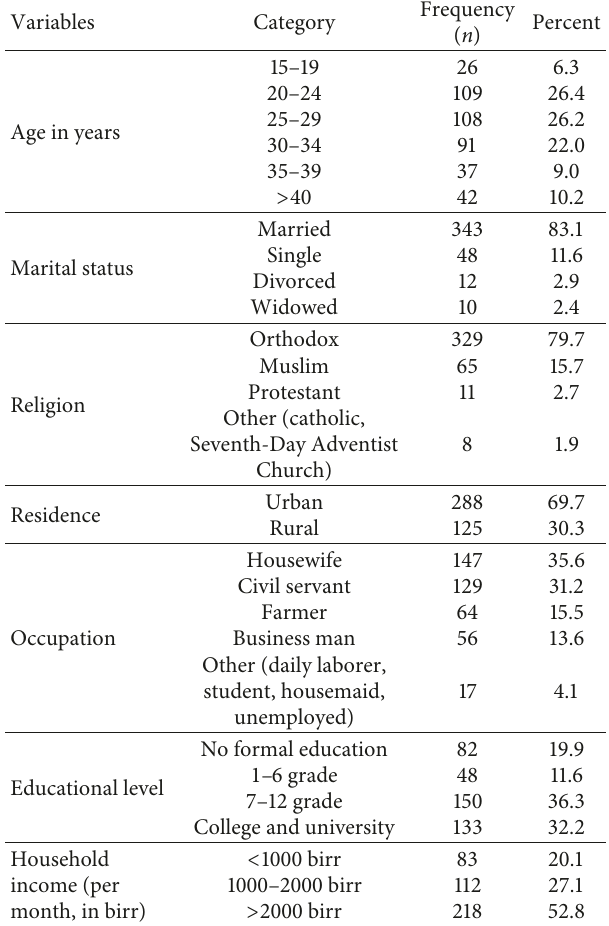
Table 2: Hospital characteristics of the respondents admitted to obstetrics and gynecology wards of public hospitals in Mekelle town, Tigray Region,